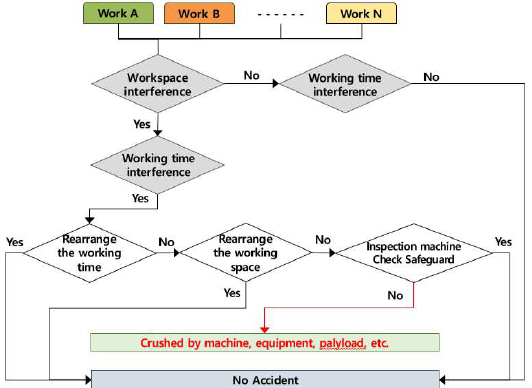
Figure 9. Mechanism of being crushed by multiple processes in the workplace (AMMP model for crushed).